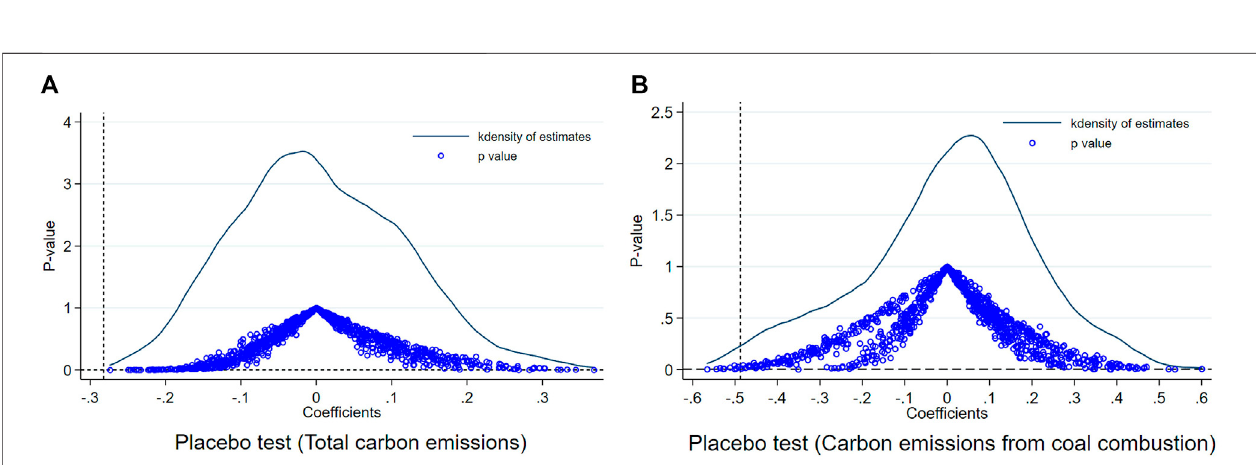
FIGURE 2 | Placebo test. (A) Placebo test (Total carbon emissions). (B) Placebo test (Carbon emissions from coal